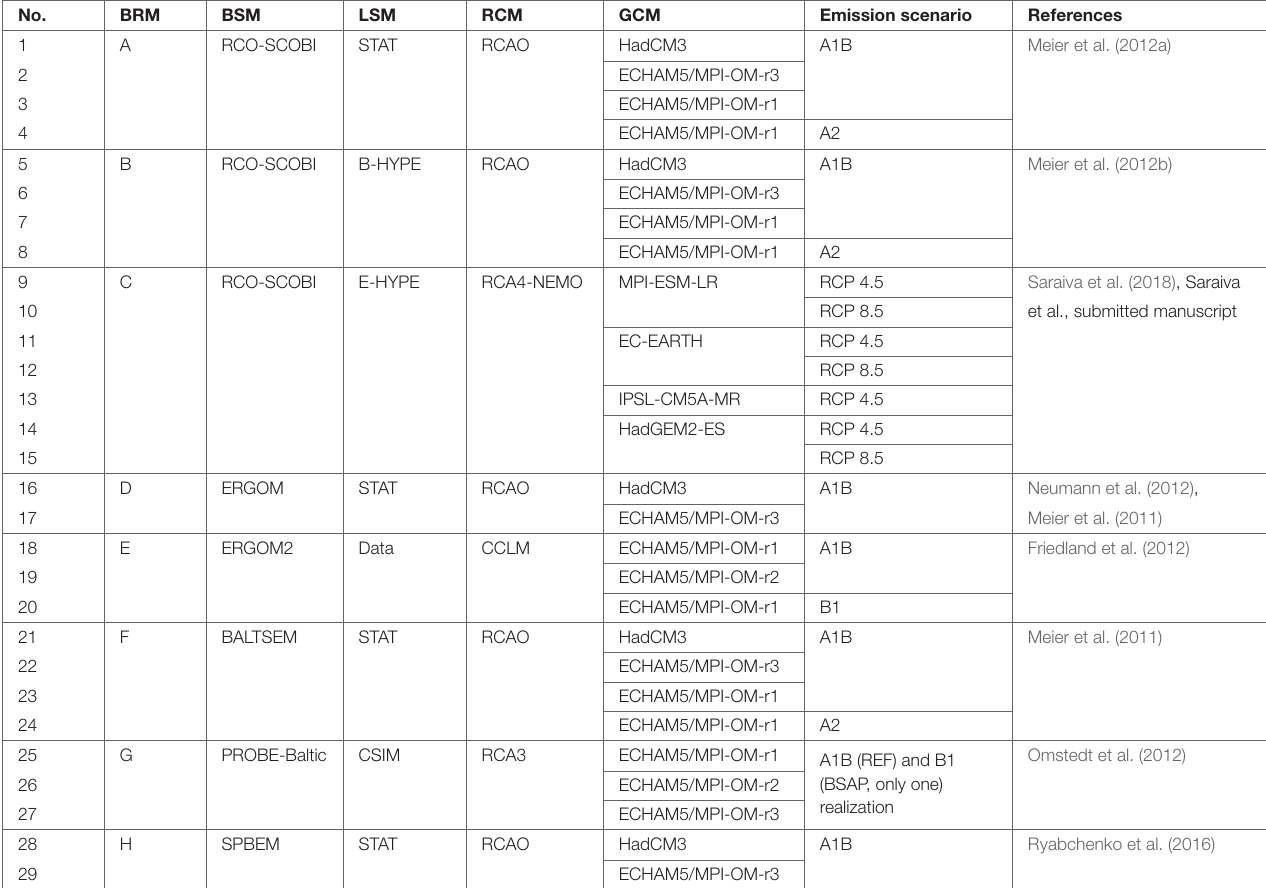
TABLE 2 | List of scenario simulations (BRM, Baltic Region Model; BSM, Baltic Sea Model; LSM, land surface model; RCM, regional climate model; GCM, global general circulation model).